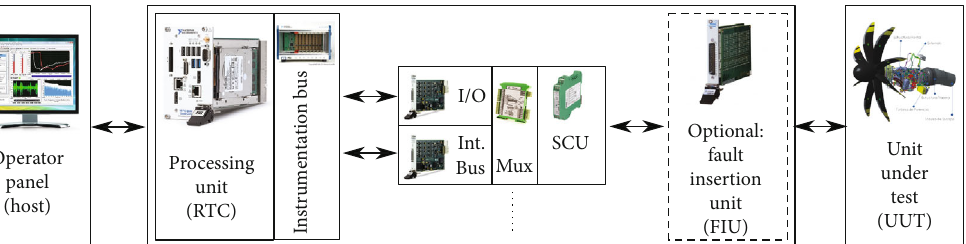
Figure 13: Multiplexed veri fi cation equipment.